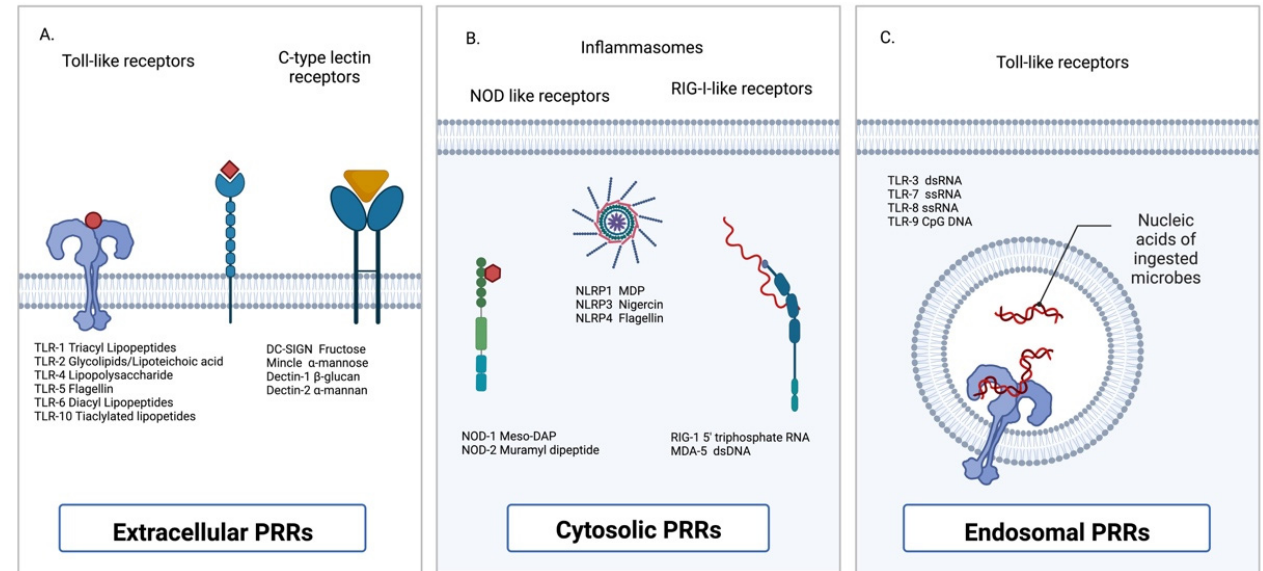
Figure 2. Cellular localization of pattern recognition receptors. ( A ) Extracellular pattern-recognition receptors (PRRs) include but are not limited to the Toll-like receptors (TLRs) and the C-type lectin receptors. ( B ) Cytosolic PRRs include the nucleotide-binding oligomerization domain (NOD)-like receptors and the retinoic acid-inducible gene 1 (RIG-I)-like receptors. ( C ) Endosomally-located PRRs are restricted to the TLRs [83].